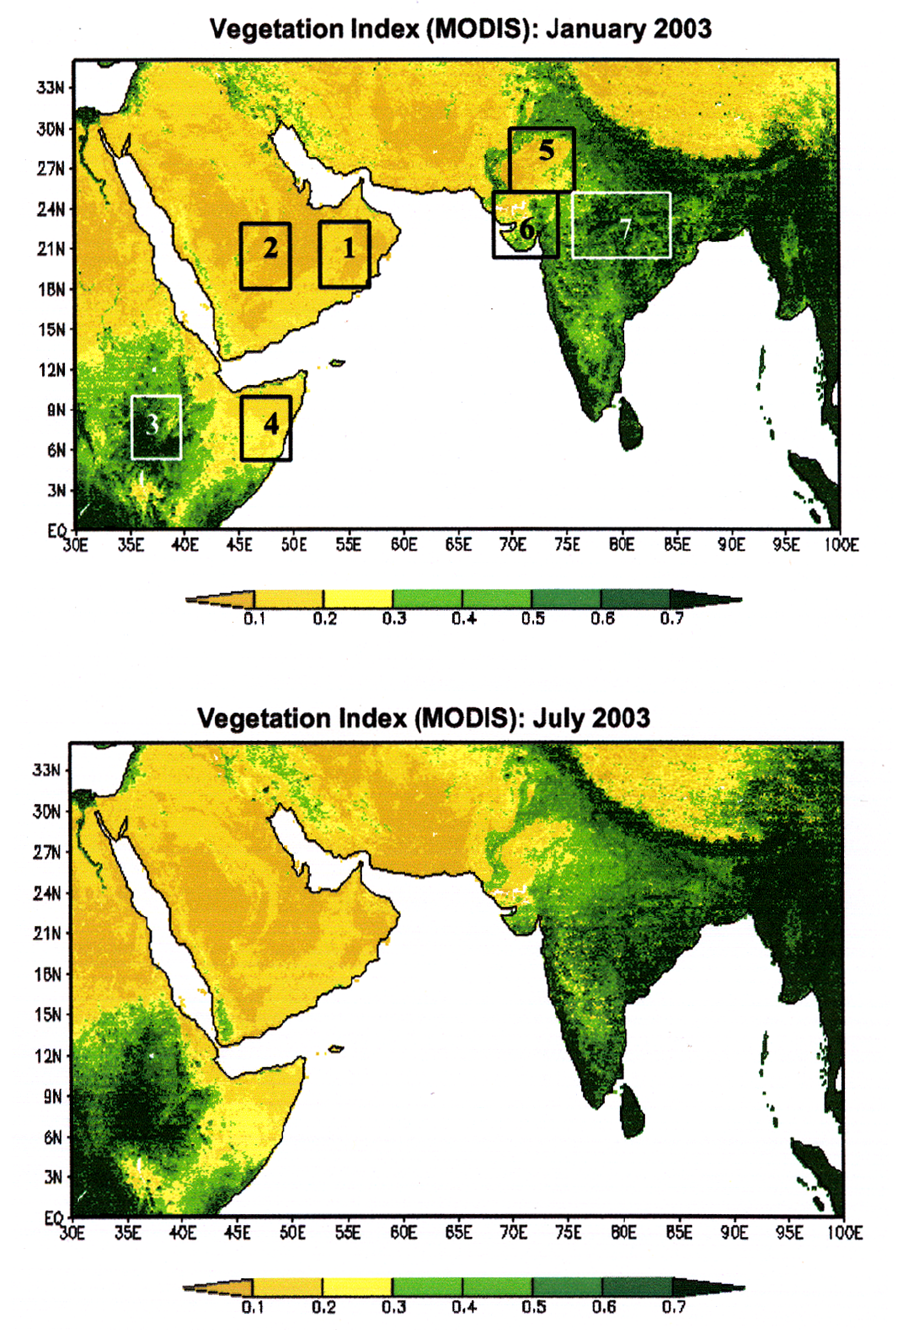
Fig. 9. Normalised Difference Vegetation Index (NDVI) maps of dry (January) and monsoon (July) months. The numbers inside the boxes represent the various regions which are used in the text to identify